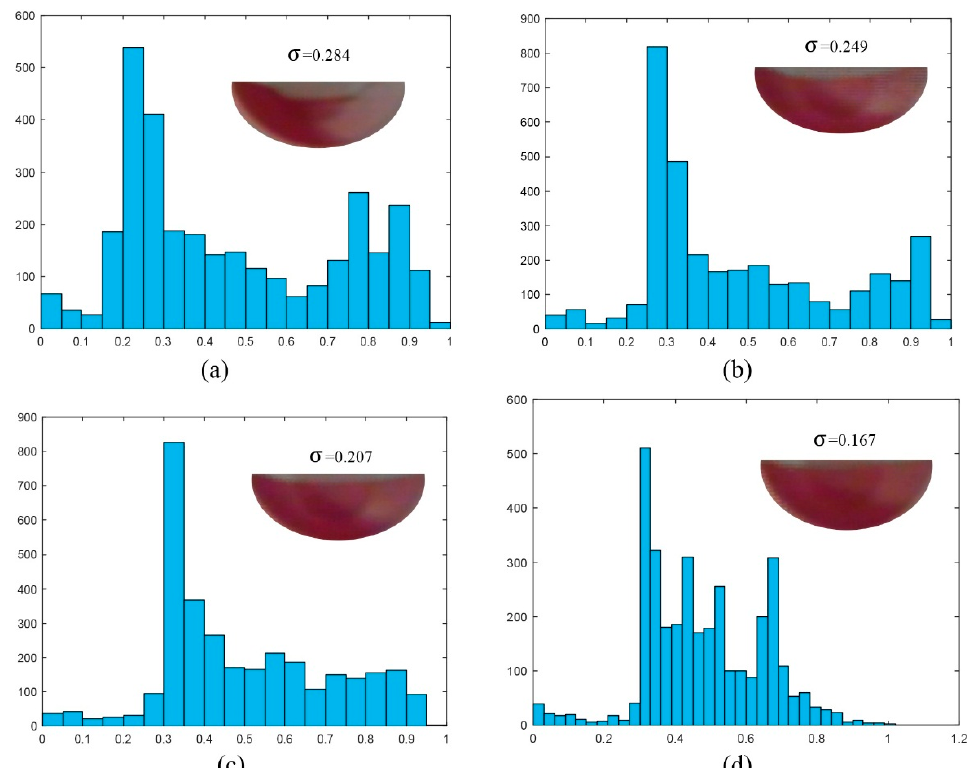
Figure 7. Histograms and standard deviations obtained from the gray intensities of the photo images of the mixing chamber after ( a ) one mixing cycle, ( b ) two mixing cycles, ( c ) three mixing cycles, and ( d ) four mixing cycles, respectively.